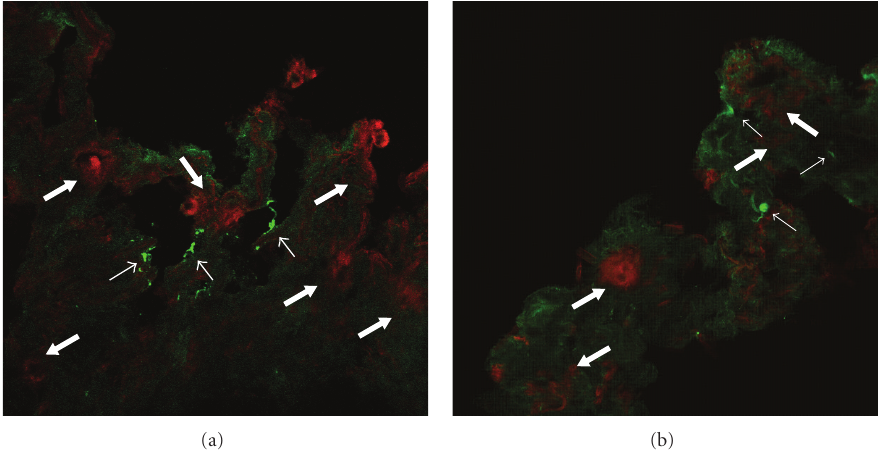
Figure 9: Distribution of immunoreactive MBP and nerve PGP 9.5 in human airway following overnight incubation with human eosinophils. Representative images of 2mm human airway incubated overnight with eosinophils. Immunoreactive PGP 9.5 (green) and MBP (red) are shown. Though some eosinophils appeared near nerves (small arrows) in the human airway (a), many eosinophils, as well as extracellular MBP deposition, occurred within the airway wall not associated with airway nerves (b) (thick arrows) under higher magnification (confocal microscopy